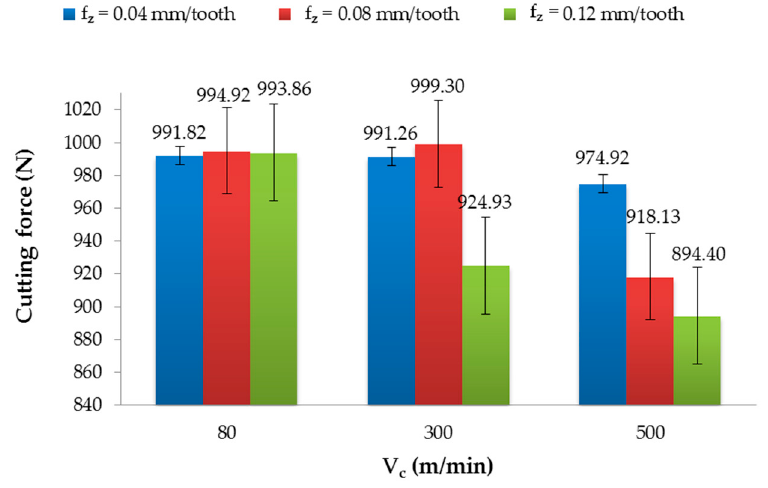
Figure 9. Cutting force in relation to the cutting speed after milling with di ff erent feeds and the TiAlN-coated tool.